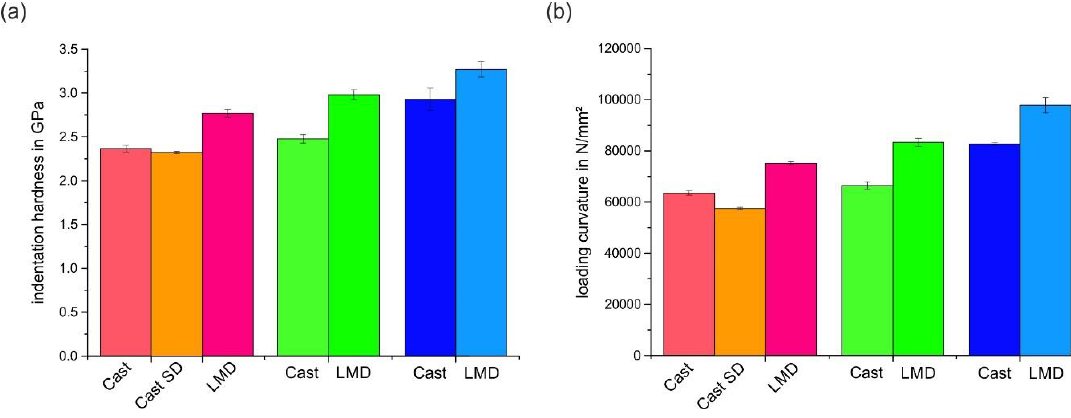
Figure 15. ( a ) Hardness H i and ( b ) loading curvature C of the investigated specimens and crystallographic orientations.